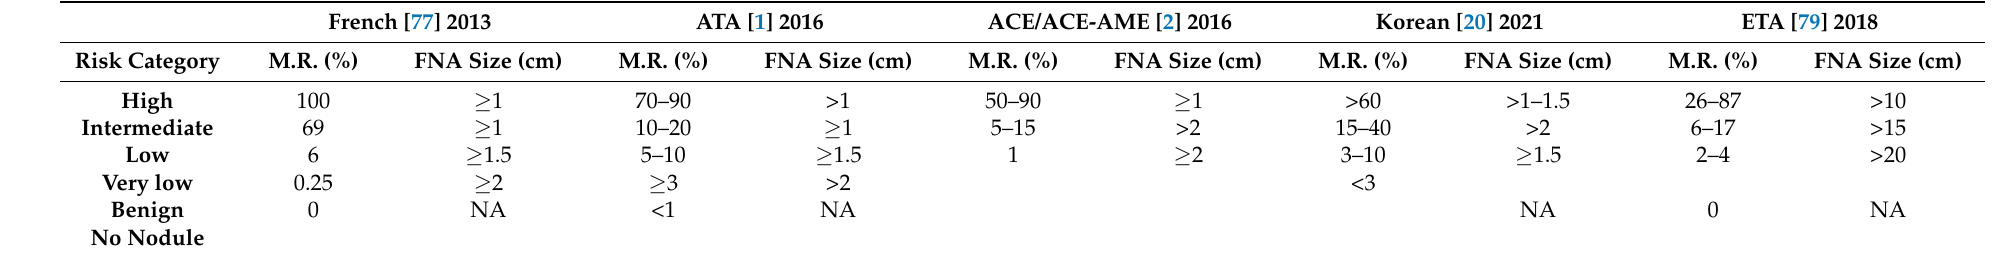
Table 2. US risk stratification for malignancy and indication for